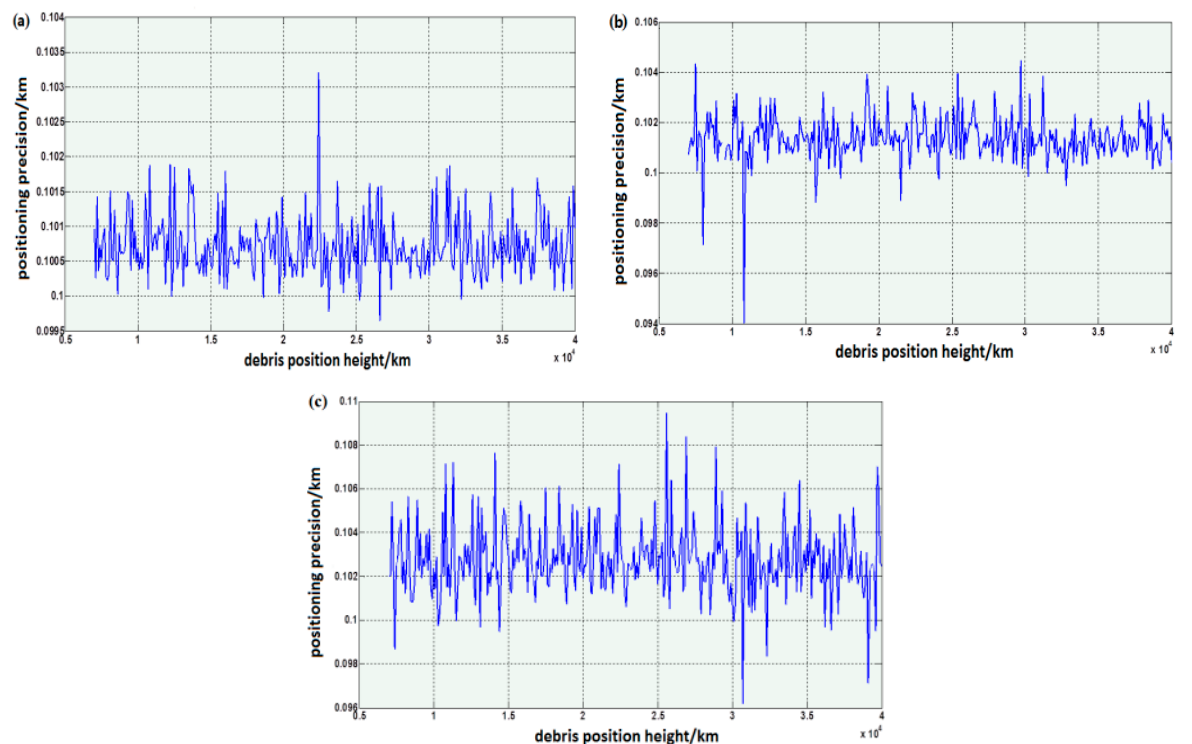
Figure 14. The positioning error of space debris varies with the height of the debris position at different observation distances when the star tracker’s own positioning error was 100 m. ( a ) The space debris observation distance of 50 km. ( b ) The space debris observation distance of 100 km. ( c ) The space debris observation distance of 200 km.